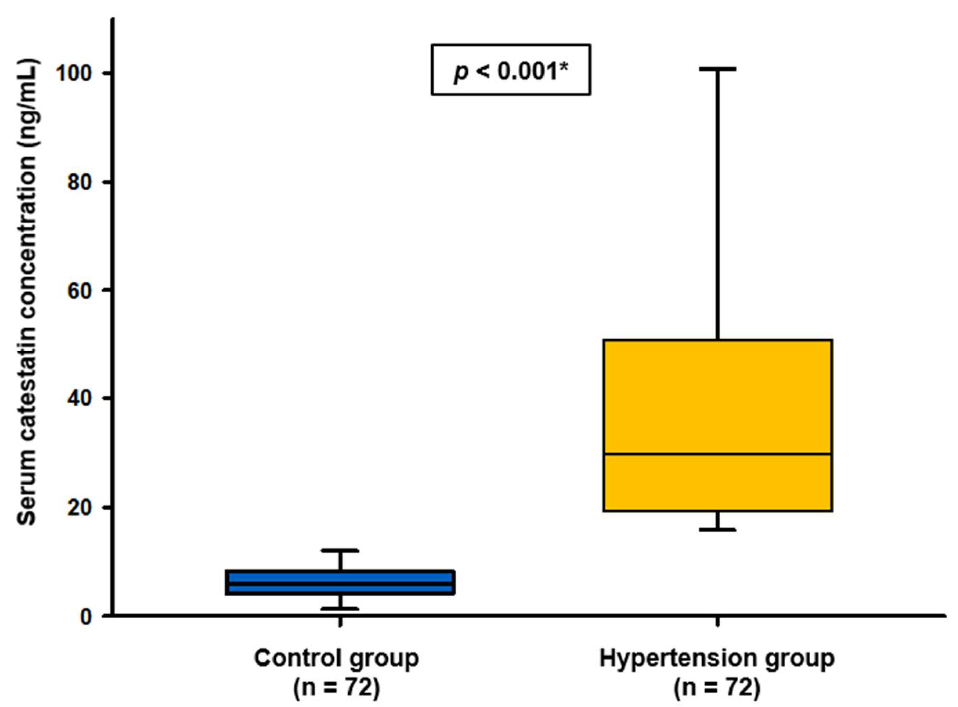
Figure 1. Comparison of catestatin concentrations between patients with primary hypertension and healthy controls. Data are presented as median and interquartile range. * Mann–Whitney U test.